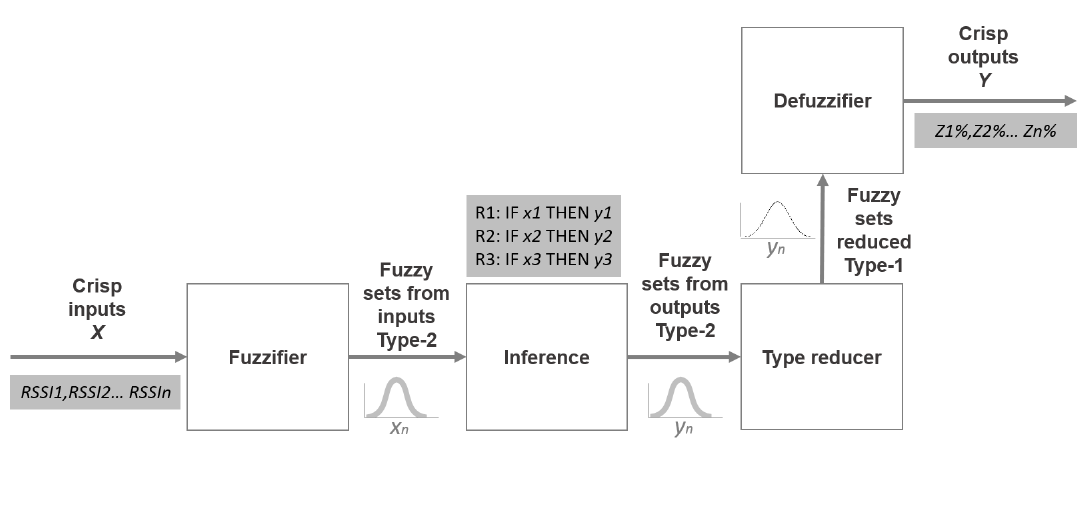
Figure 10. Type-2 fuzzy inference system (FIS) structure.